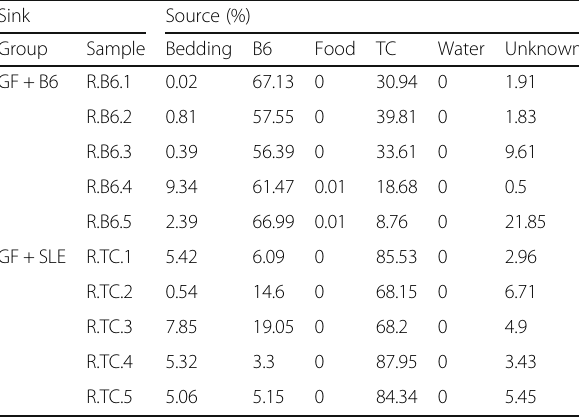
Table 3 SourceTracker results for mice in the GF + B6 group and the GF + SLE group Sink Source (%) Group Sample Bedding